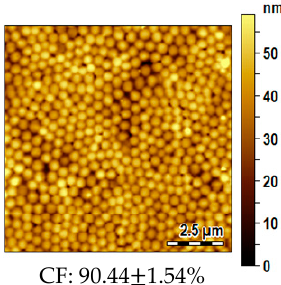
Figure 8. AFM image of the MGs film realized onto the silanized glass fiber tip, following the optimized procedure.